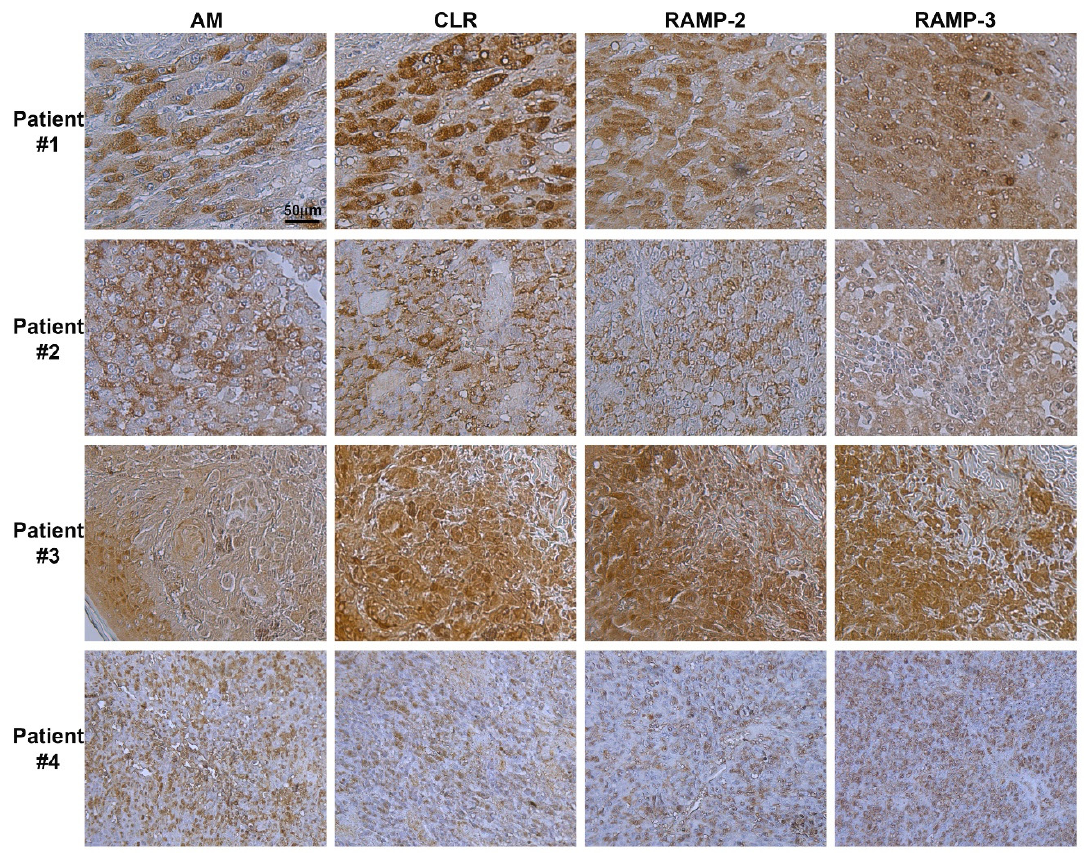
Figure 1. Expression of AM and its receptors in human melanoma. Immunohistochemistry for AM, CLR, RAMP2, and RAMP3 in melanoma tissue. Strong cytoplasmic staining for AM, CLR, RAMP2, and RAMP3 is observed in melanoma cells. Stroma cells with weaker cytoplasmic staining are also